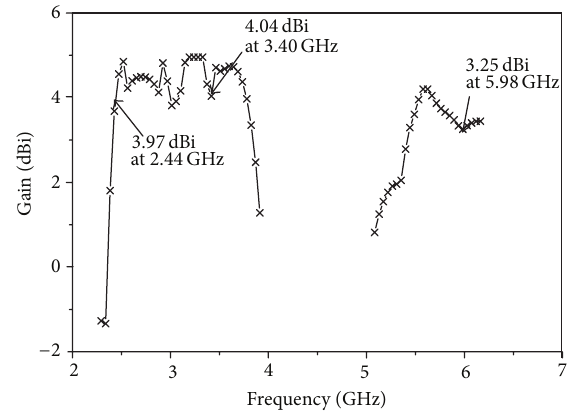
Figure 15: Measured gain of the proposed